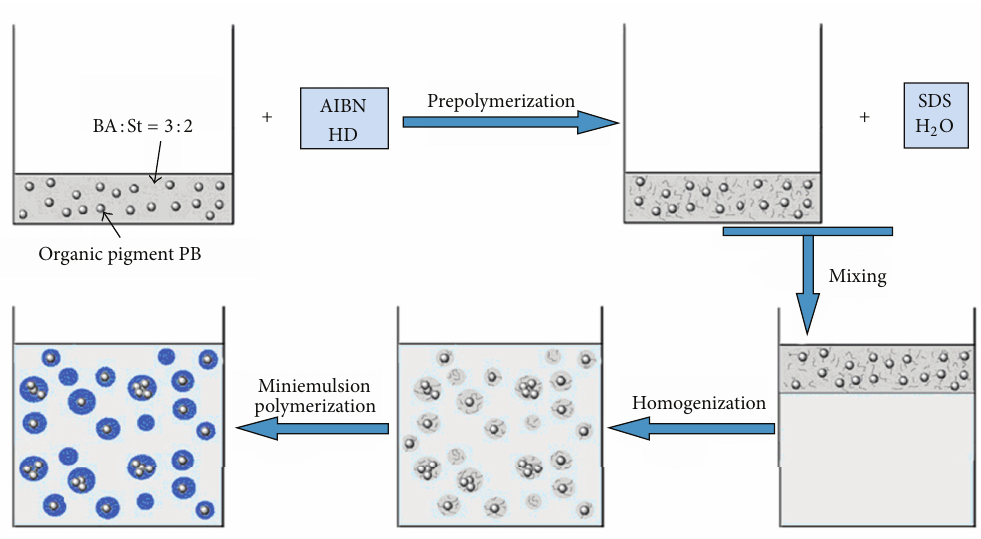
Figure 1: Schematic representation of the formation of self-adhesive polymer/organic pigment nanocomposites via miniemulsion poly- merization.